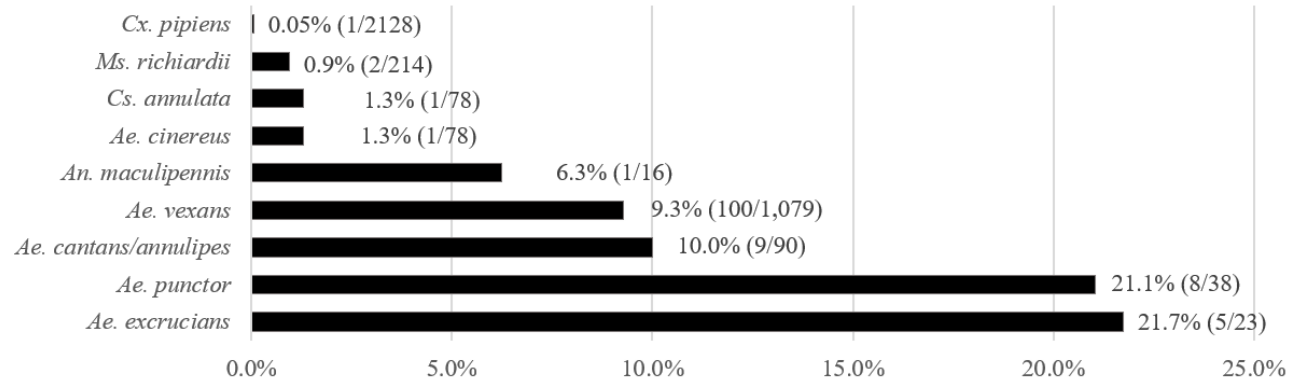
Figure 1. MIR of T. theileri for individual species with at least 15 examined individuals. Mosquito species are ordered by prevalence.